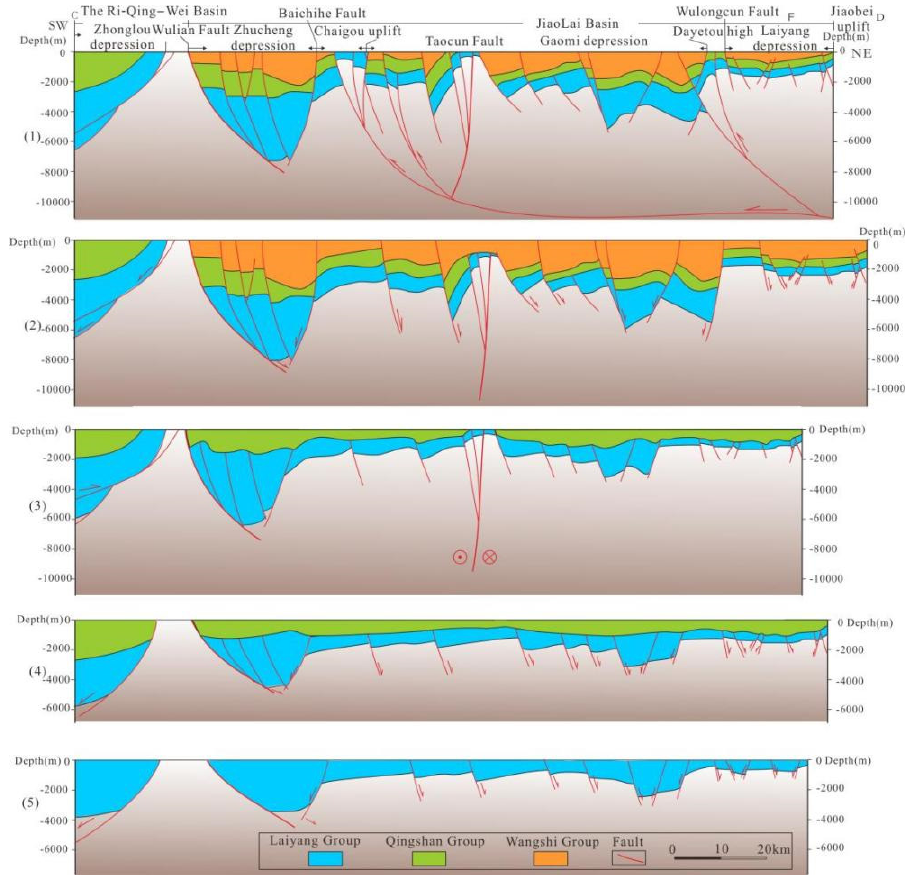
Figure 5. Profile of tectonic evolution map of southwest − northeast trending section in the Jiaolai basin (see Figure 1 for section location): (1) late Wangshi period; (2) Wangshi period; (3) late Qingshan period; (4) Qingshan period; and (5) Laiyang period.